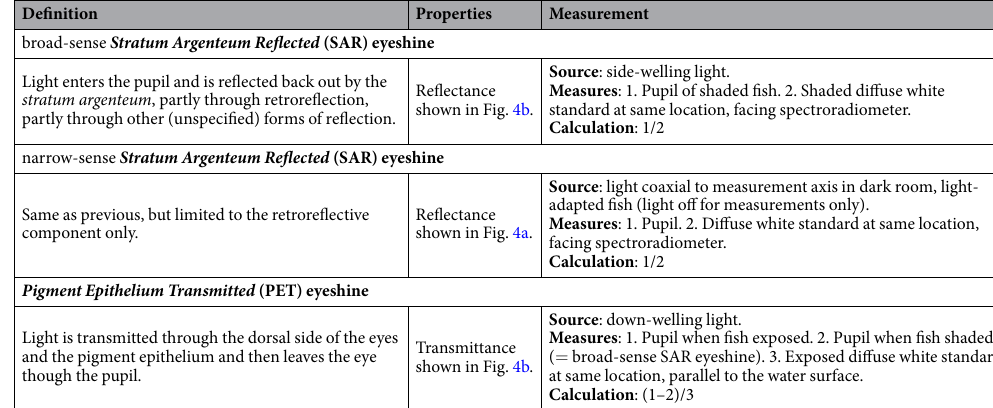
Table 1. Definitions. Eyeshine in the scorpionfish Scorpaena porcus is a combination of two different mechanisms, SAR and PET eyeshine: SAR eyeshine is strongly affected by a retroreflective component (‘narrow-sense SAR’), which was quantified independently. This overview table defines and summarizes the properties of these mechanisms. ‘Calculation’ numbers refer to indexed ‘Measures’. See Fritsch et al . (2017) for an overview of eyeshine types 13